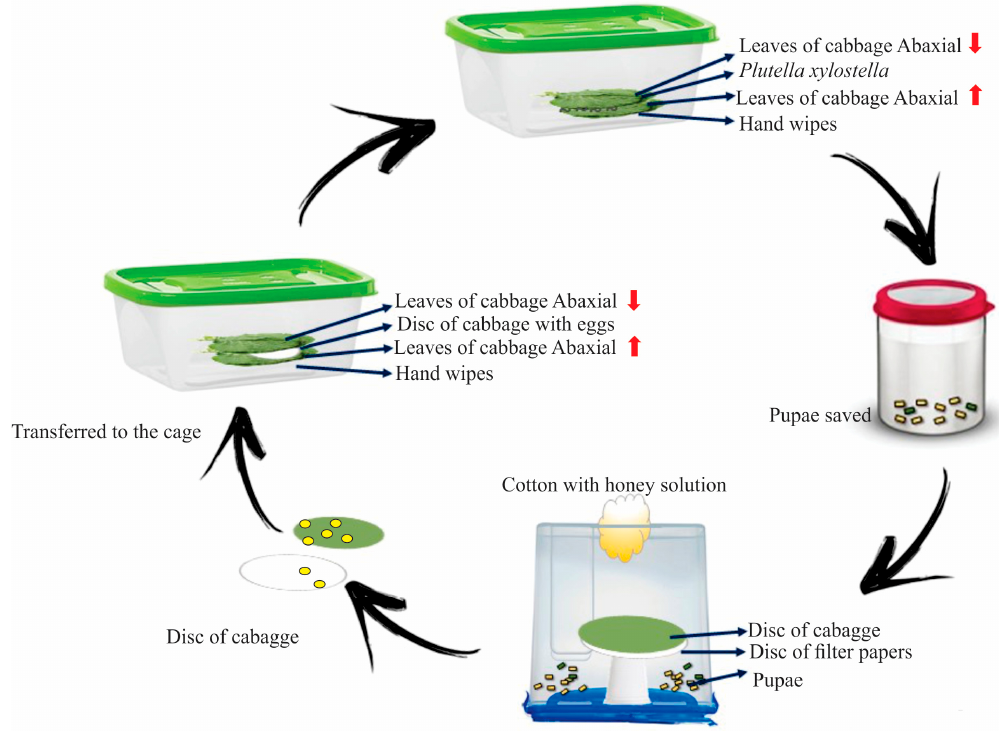
Figure 1. A schematic representation of the methodology used for rearing Plutella xylostella , by Matias da Silva et al. [34].